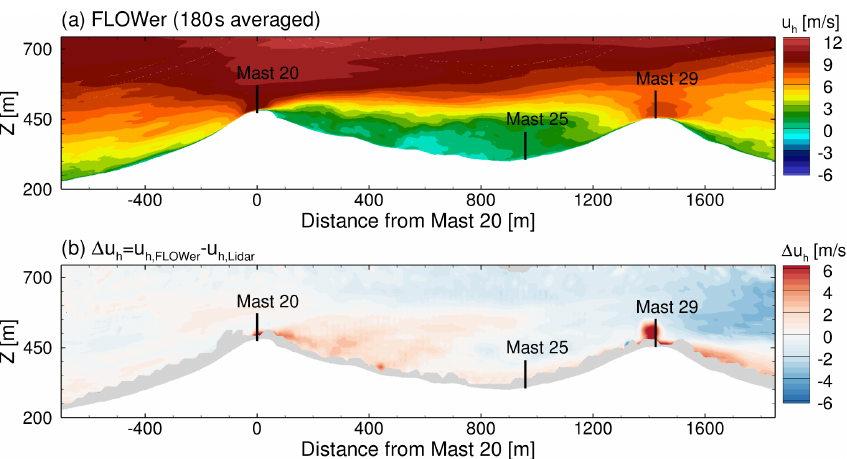
Figure 8. Horizontal component of the line-of-sight velocity in the DTU lidar plane, simulated with FLOWer (a) and difference from measurement (b) .